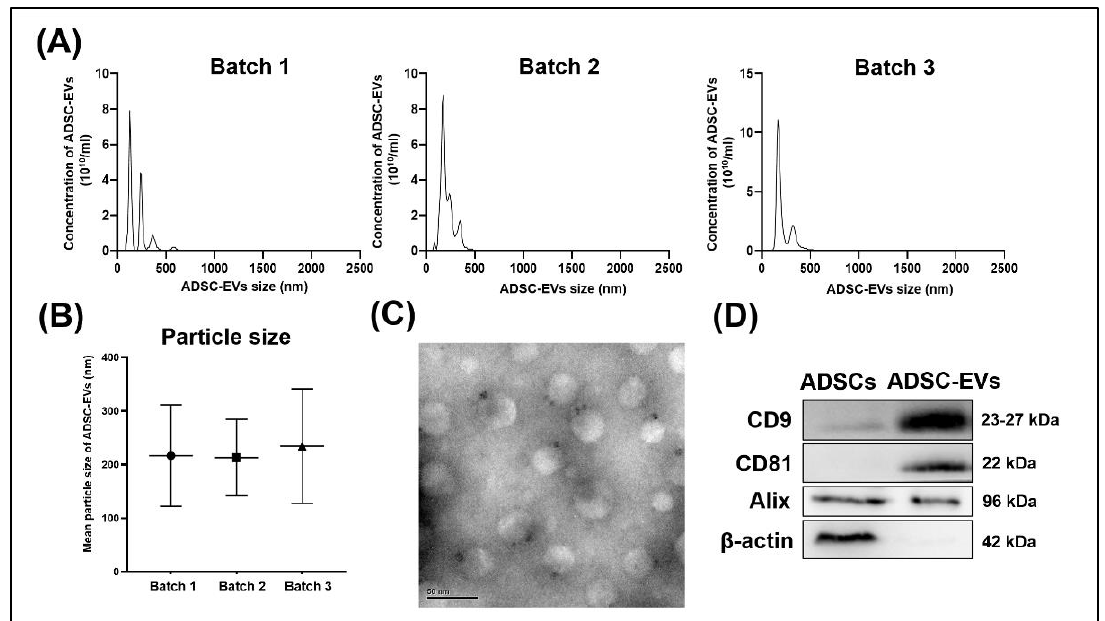
Figure 1. Characterization of ADSC-EVs. ADSC-EVs were isolated from three separate batches of conditioned media (CMs) and characterized. ( A ) Particle size distribution of ADSC-EVs measured through a nanoparticle tracking analysis (NTA). ( B ) Mean particle sizes of ADSC-EVs measured through NTA. Data are presented as the mean ± standard deviation (SD; n = 3). ( C ) Morphology of the ADSC-EVs as observed through transmission electron microscopy. ( D ) Western blot analysis of the protein levels of CD9, CD81, Alix , and β-actin in ADSCs and ADSC-EVs.